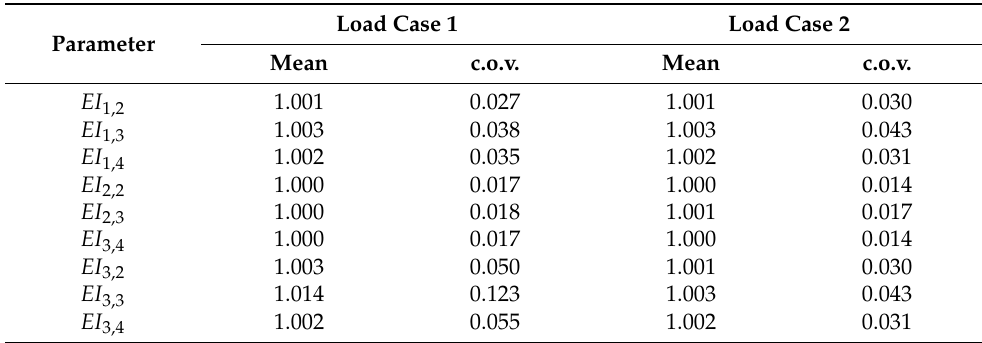
Table 2. Statistical summary of the estimations using different strategies.